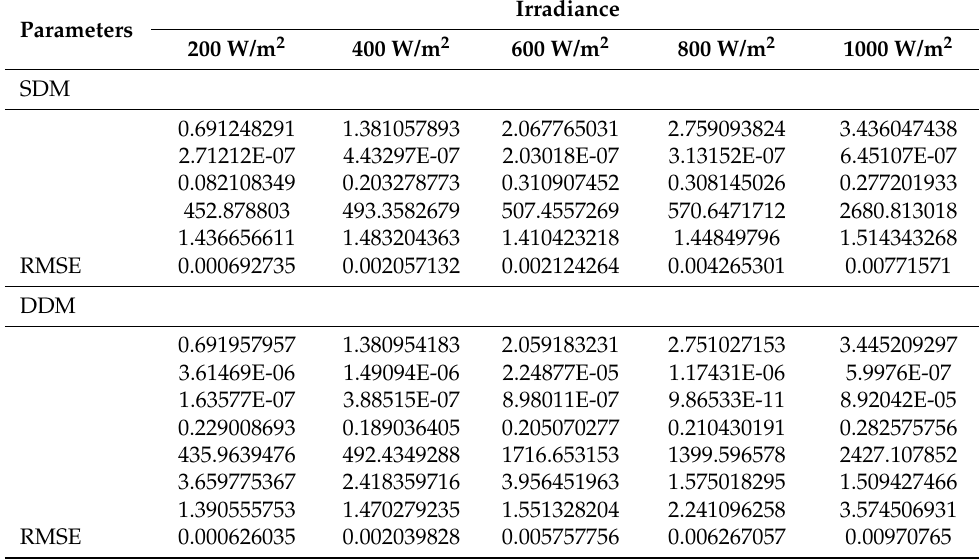
Table 15. Optimal parameters with various irradiance under 25 °C on SM55.